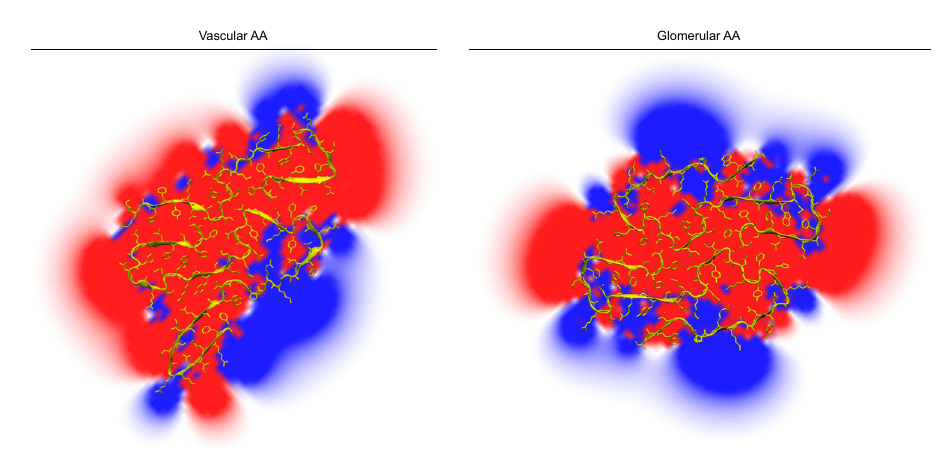
Fig.6|Electrostaticpotentialofthevascularandtheglomerular fi bril. Theelectrostaticpotentialofasinglelayerofthevascular(left)andtheglomerular(right) fi bril. Blue: positive charges; red: negative